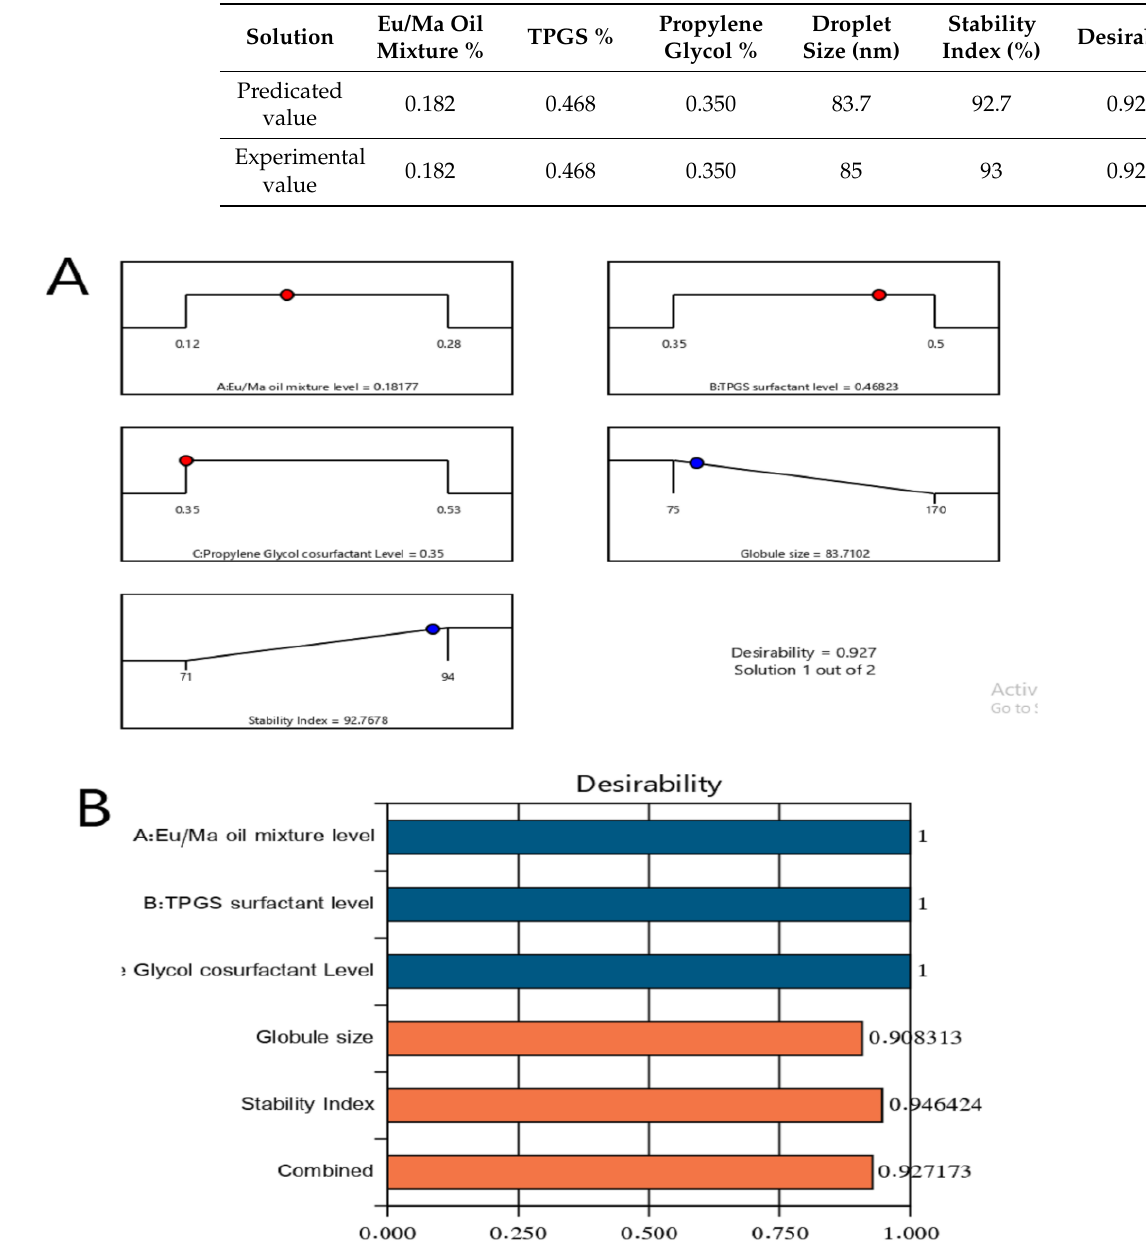
Figure 4. Bar chart and desirability ramp for optimization process. The desirability ramp illustrates the levels of studied factors and expected values for the dependent variables of the optimized LV- Eu-SNEDDS ( A ). The bar chart illustrates the values of desirability for the conjugated responses ( B ). Table 3. Actual and predicted values of the optimized